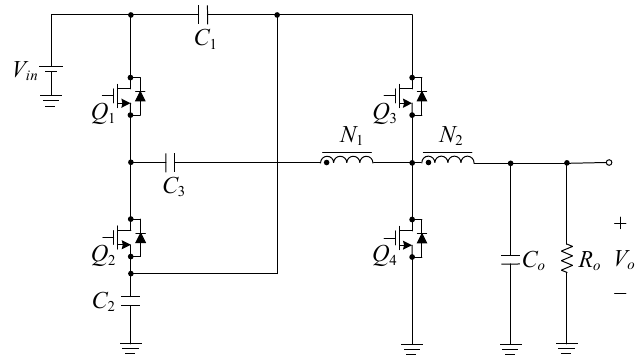
Energies 2019 , 12 , x FOR PEER REVIEW Figure 1. Proposed improved ultrahigh step-down converter. Figure 1. Proposed improved ultrahigh step-down converter.